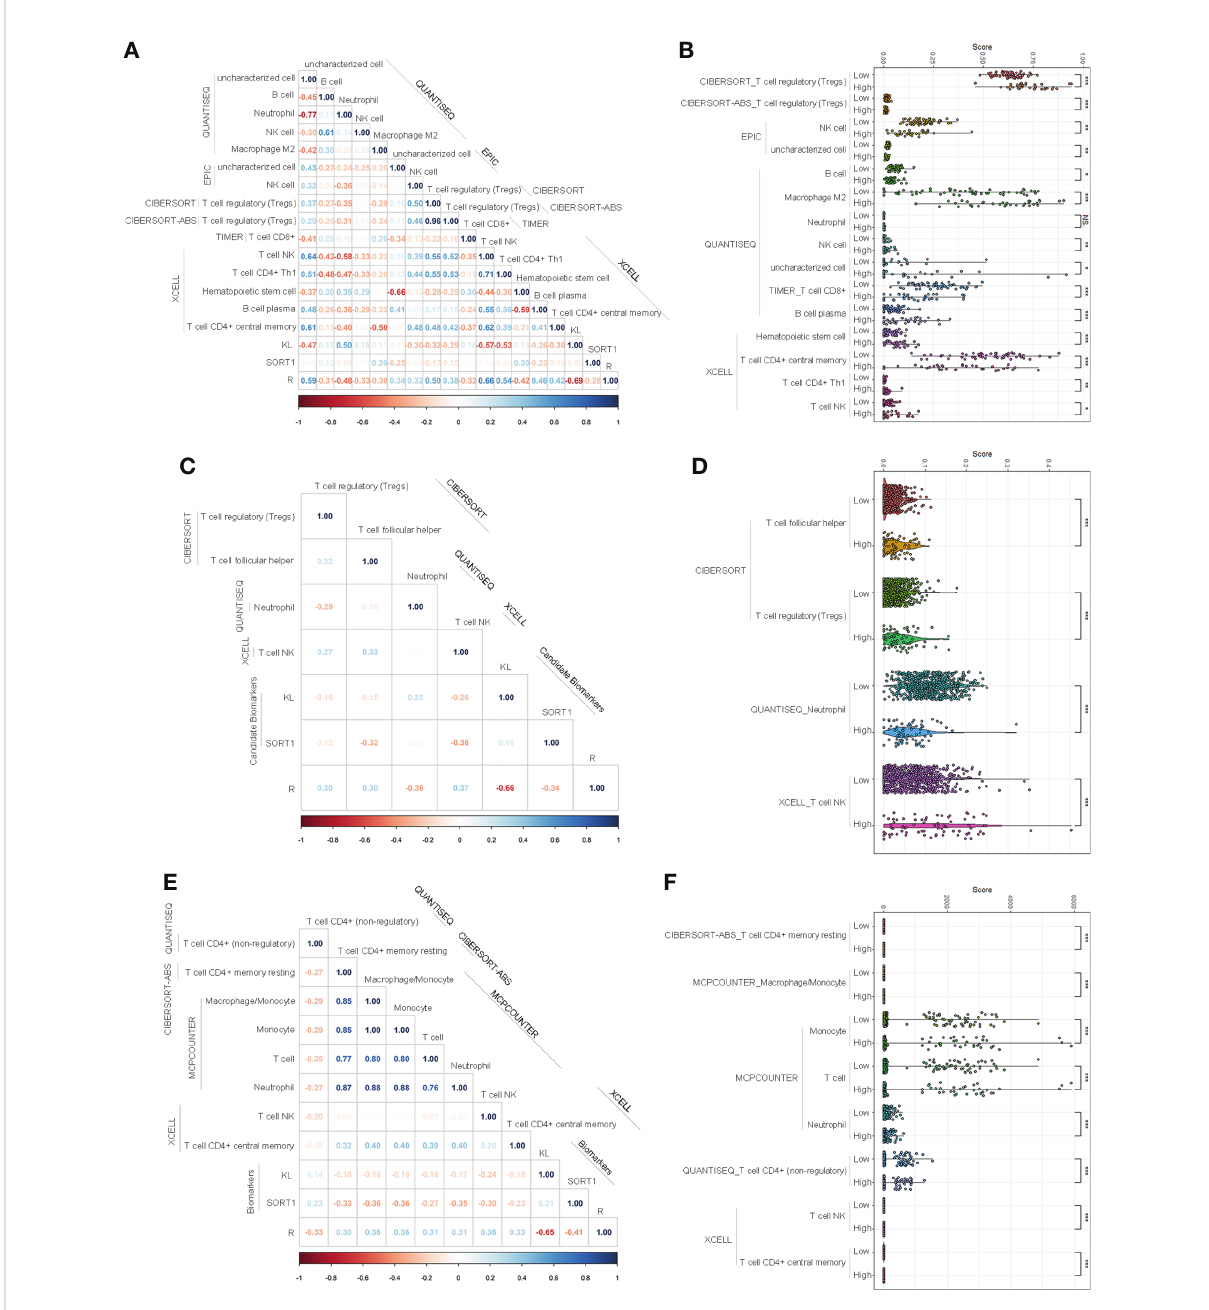
FIGURE 5 Investigation of immune in fi ltration landscapes. (A, B) Correlation analyses (A) and difference analyses (B) of several immune cells and factors with signi fi cant correlation with the prognostic model in the training group. (C, D) Correlation analyses (C) and difference analyses (D) of several immune cells and factors with signi fi cant correlation with the prognostic model in validation group. (E, F) Correlation analyses (E) and difference analyses (F) of several immune cells and factors with signi fi cant correlation with the prognostic model of the entire group. *p < 0.05; **p < 0.01; ***p < 0.001. NS means No Signi fi